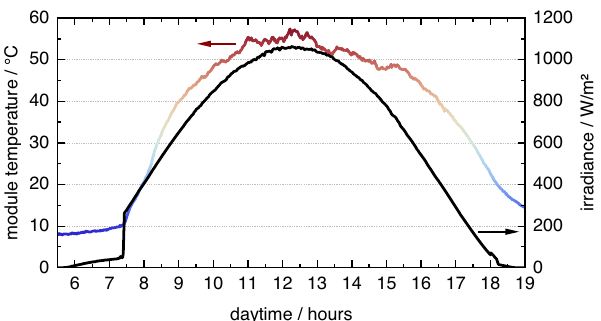
Fig. 2 External conditions on the solar module during the daytime of September 9, 2020. The irradiance (black line) on the module plane has basically a trigonometrical dependence on the time of day. The drop from 6 am to 7:30 am is due to trees that block the sunlight. The measured module temperature (blue-red line) has the same behavior as the irradiance but lags behind it.